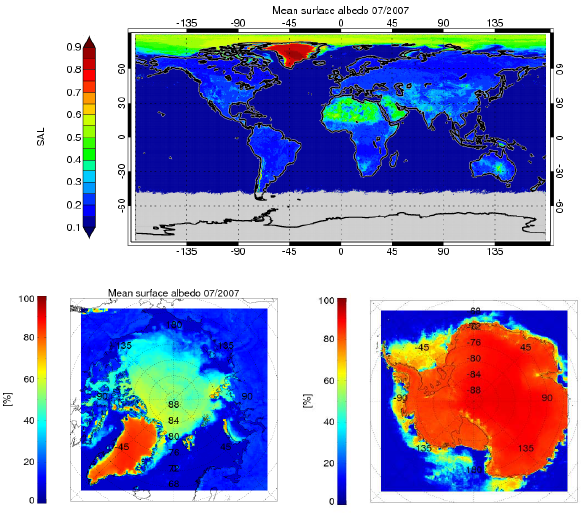
Fig. 7. Global monthly mean surface albedo for July 2007 (top). Figure 7. Global monthly mean surface albedo for July 2007 (top). Corresponding plots for 6 Corresponding plots for two polar grids are shown at the bottom of two polar grids are shown at the bottom of the figure; one for the Arctic region (bottom left) 7 the figure: one for the Arctic region (bottom left) and one for the and one for the Antarctic region (bottom right, but observe that the month here is January 8 Antarctic region (bottom right, but observe that the month here is instead of July). Regions without values are grey-shaded (here resulting from dark conditions 9 January instead of July). Regions without values are grey-shaded prevailing close to Antarctica during the Polar winter). 10 (here resulting from dark conditions prevailing close to Antarctica during the polar winter). 1